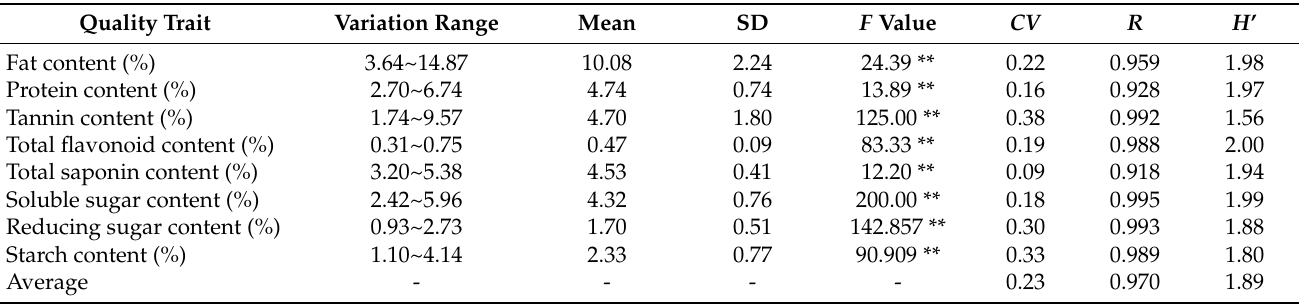
Table 4. Genetic diversity of fruit quality traits in H. acerba